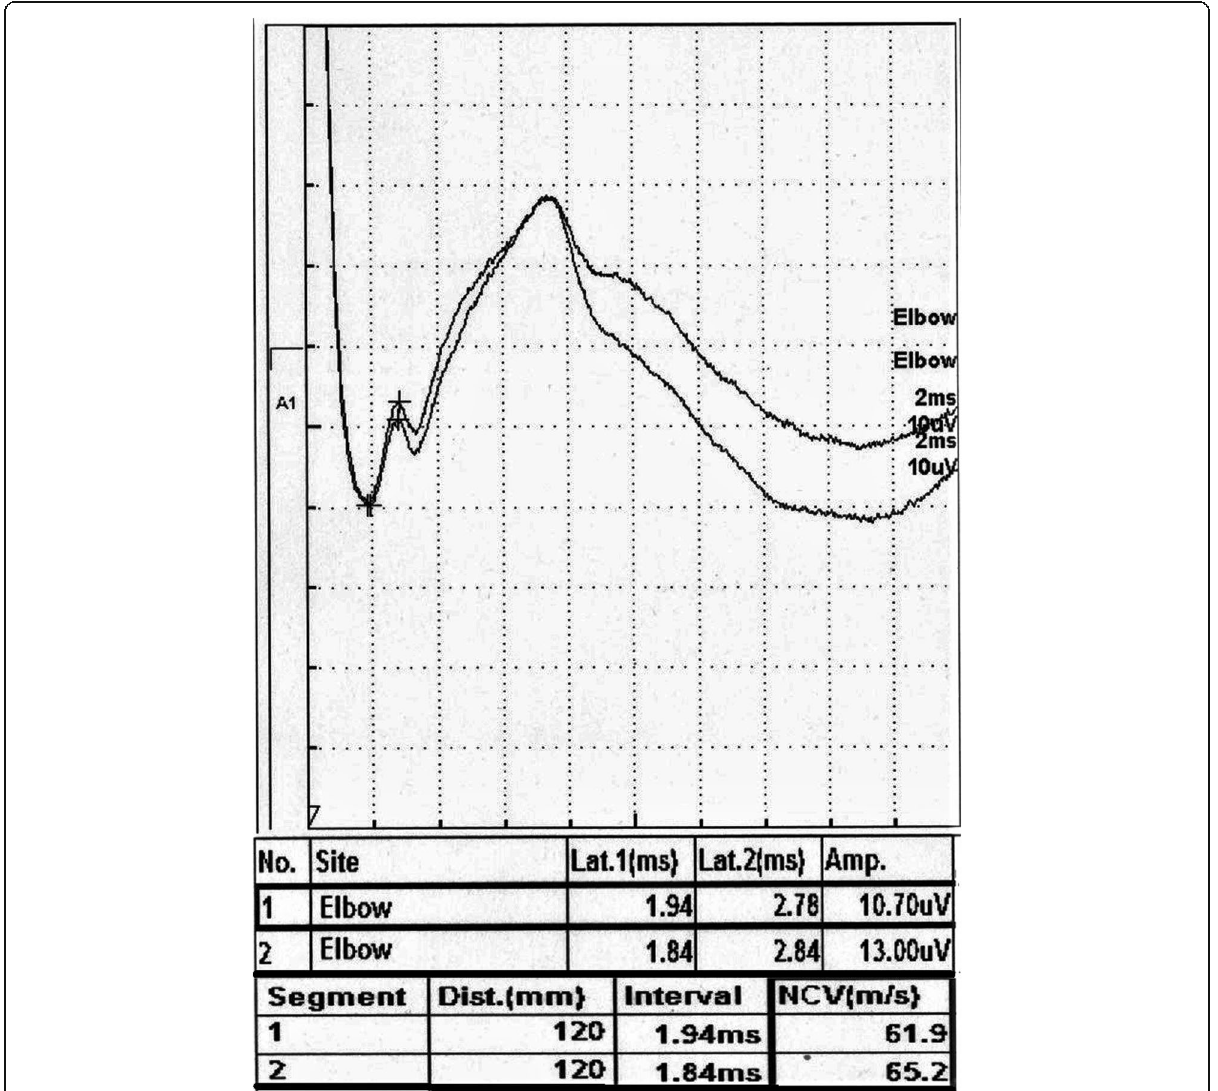
Fig. 3 Posterior antebrachial cutaneous sensory nerve action potentials (SNAP) of an apparently healthy woman (the two potentials are superimposed). Each SNAP is followed by a large volume-conducted motor potential of the forearm extensor muscles